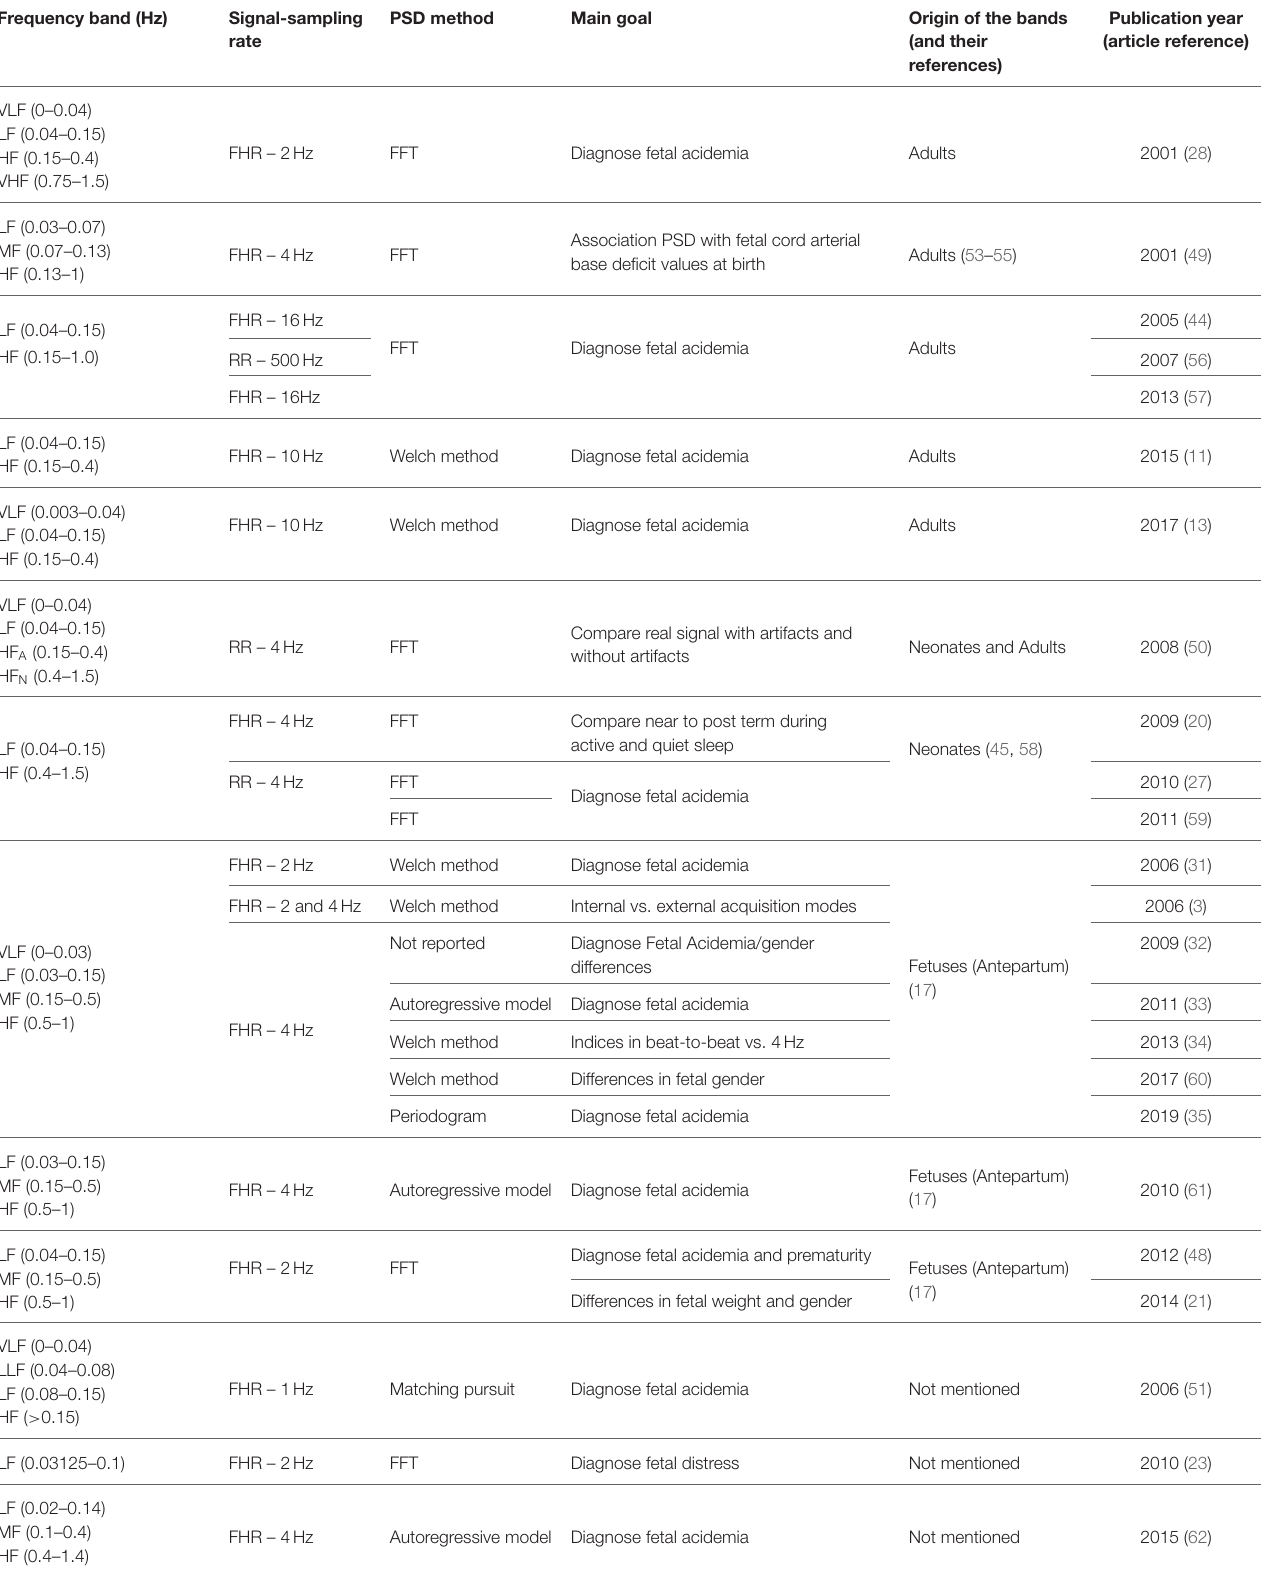
TABLE 1 | Information on different frequency bands and related contents of the 24 articles